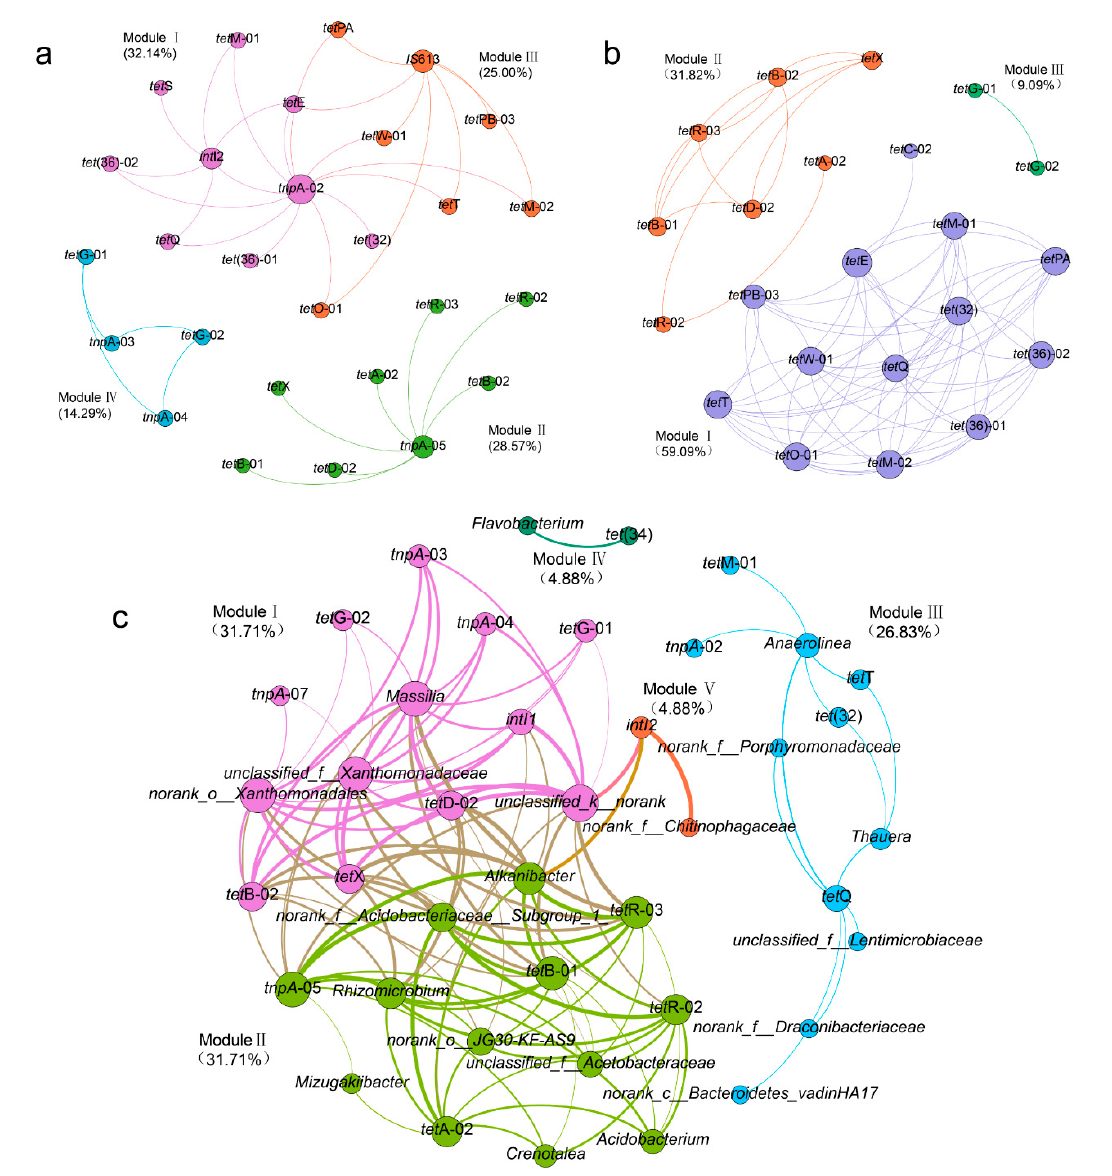
Figure 5. Network analysis: ( a ) predicts the dissemination of specific TRGs facilitated by MGEs, ( b ) reveals the co-occurrence of TRGs, ( c ) identifies the potential hosts of TRGs and MGEs.